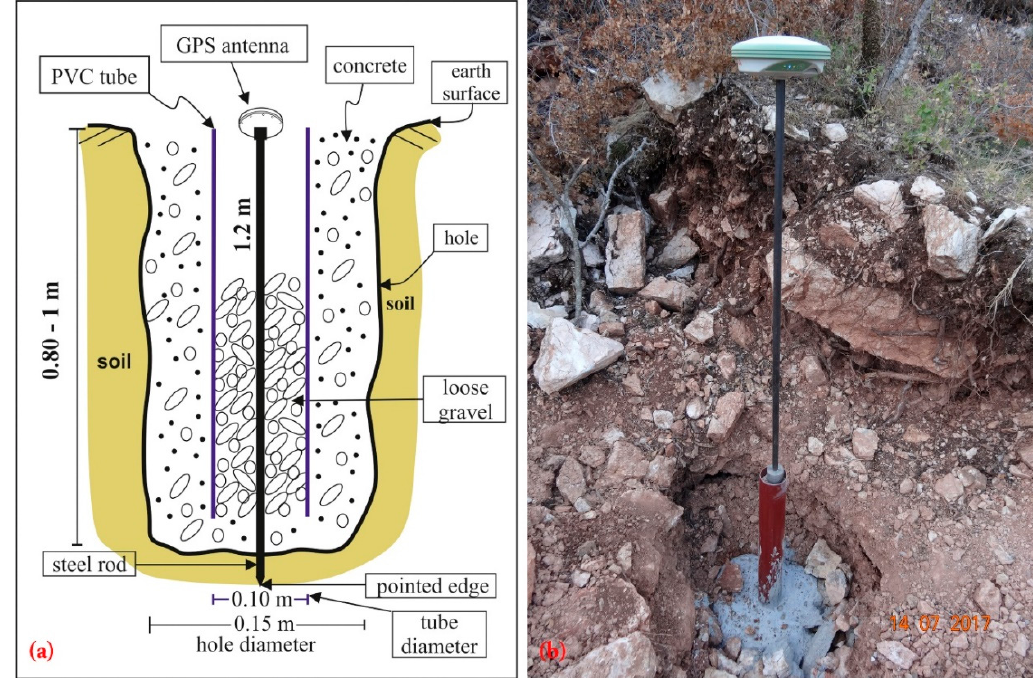
Figure 3. ( a ) Sketch showing the different parts of the pillar assembled by the steel rod and a PVC tube. The sketch is not to scale. ( b ) Photo of a representative pillar (monument) during the July 2017 campaign.